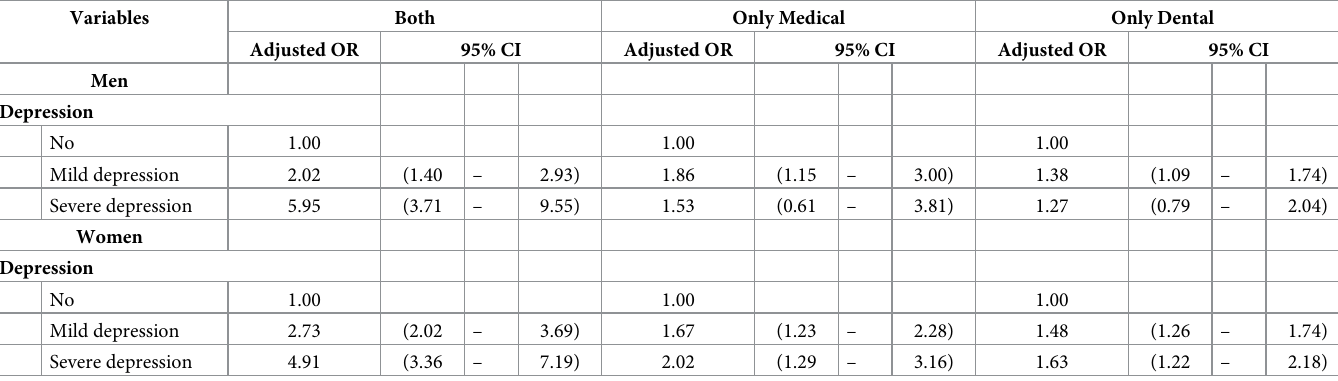
Table 5. Factors associated with the type of unmet healthcare needs a .